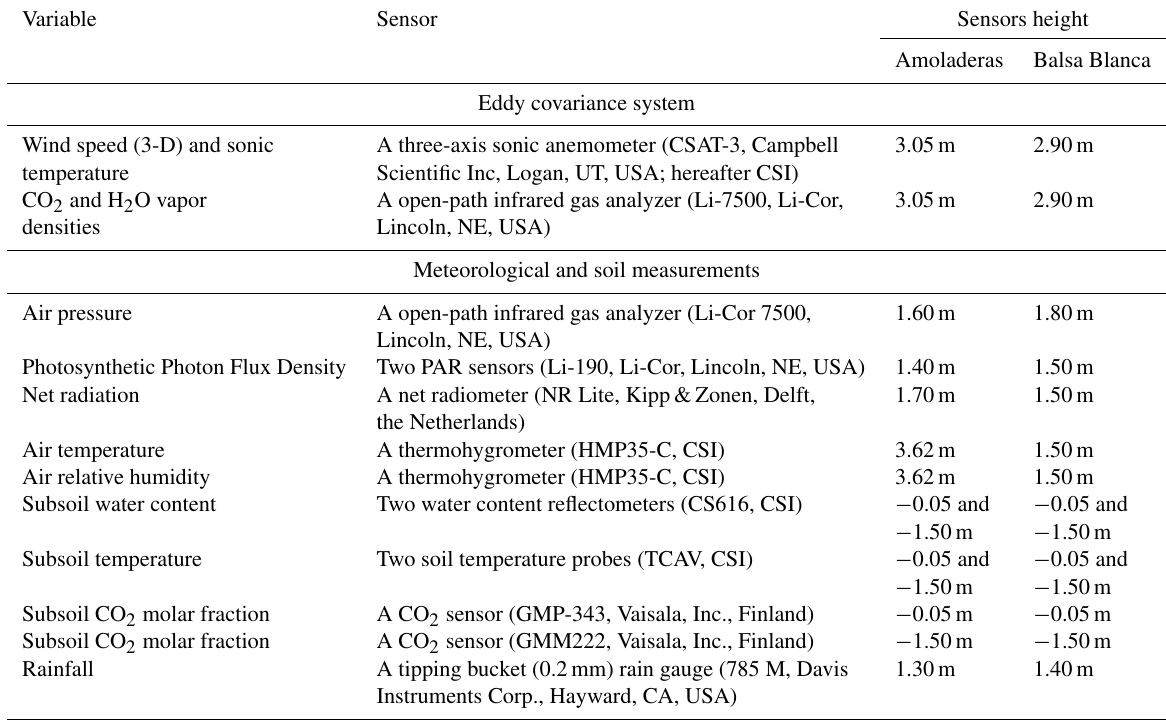
Table 2. Variables measured, sensors used and their installation height in Amoladeras and Balsa Blanca experimental sites. Variable